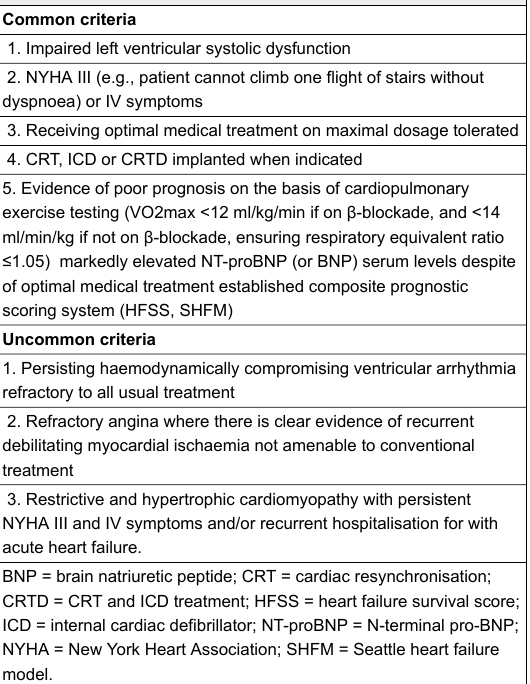
Table 1: Criteria for heart transplantation.